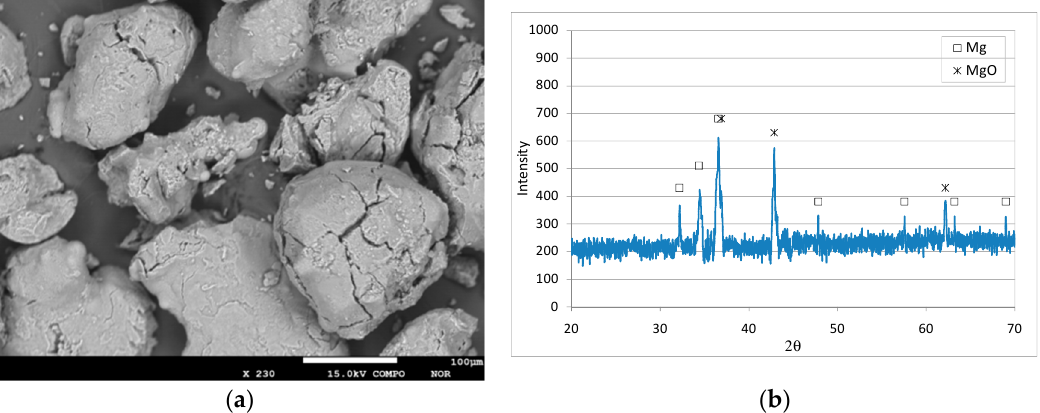
( b ) Figure 8. SEM image ( a ) and XRD diffractogram ( b ) of Mg 0 particles after the treatment of the solution with initial N-NO 3 − = 20 mg/L at pH 7. 4. Conclusions The experimental investigation carried out in this work allowed us to analyze and model the nitrate reduction process by means of zero-valent magnesium particles. In particular, through performing a large number of batch tests, the concurrent effects of pH, initial nitrate concentration and Mg 0 dosage on process performances were identified. At pH 3, for a given initial nitrate concentration, the dose of Mg 0 largely affected the process efficiency. Indeed, with a Mg/N Ni ratio of 0.33 g/mg a nitrate abatement of about 91% was reached in only 5 minutes, and a complete denitrification after 30 min. By operating with this ratio, it was estimated that about 4.53 moles of magnesium were consumed per mole of nitrate reduced, quite close to the theoretical stoichiometric values. An increase in Mg 0 dose beyond the above value did not produce any improvement of the treatment. The reaction products’ trends in response to the variation of operating conditions were also examined. The nitrite curves showed initial growth phases followed by consumption trends. The ammonium nitrogen concentration assumed increasing trends; however, with a greater Mg/N Ni ratio, after initial growth phases, the N-NH 4+ decreased to reach values close to zero. The main reaction product was gaseous nitrogen, which exhibited cumulative behaviors, with asymptotic increasing values in response to Mg/N Ni enhancement. By holding the pH at 3 and the Mg 0 at 2 g, the process performance deteriorated when increasing the influent nitrate nitrogen beyond 20 mg/L, corresponding to a ratio of Mg/N Ni = 0.33 g/mg. Indeed, the reaction rates progressively decreased and,with the higher nitrate concentrations, it was not possible to reach complete denitrification. Moreover, an increase in the final fraction of ammonium